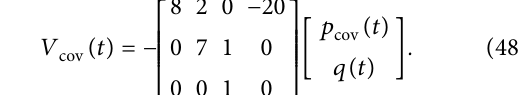
Figure 9: Control signal